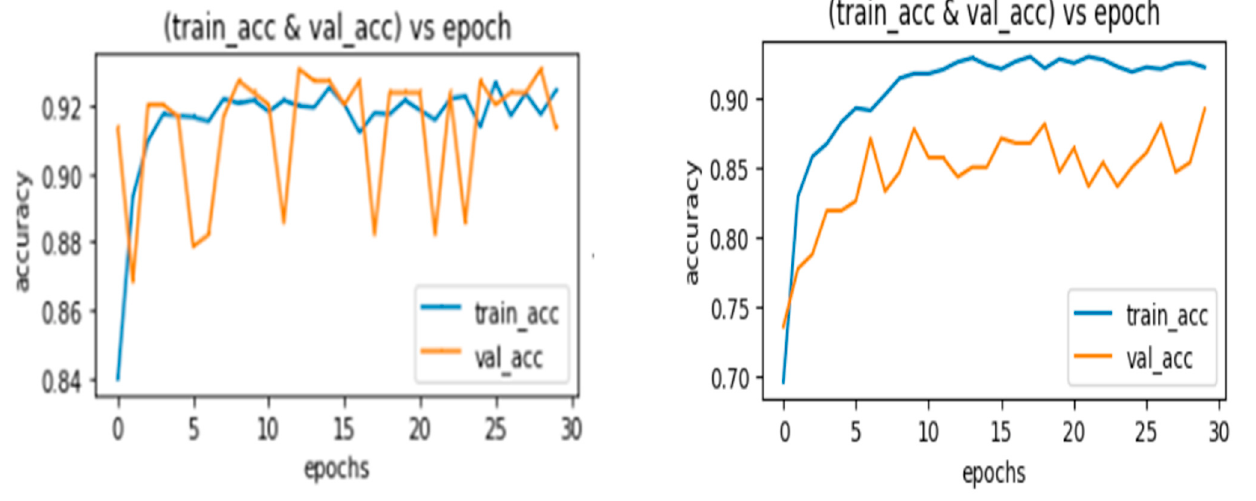
Figure 6. Comparison of different learning rates for the MobileNetV2 model.